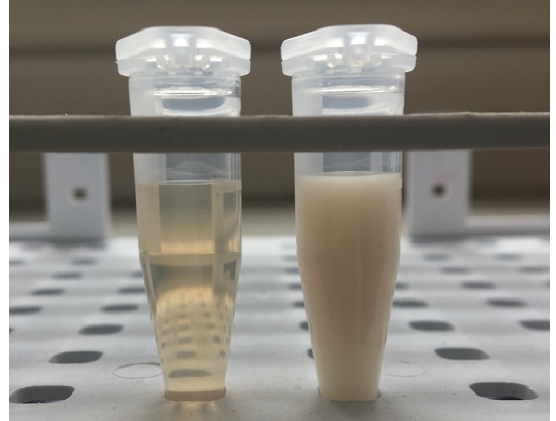
Figure 4. Apparent visual difference between the two matrixes used in the study, the normal rabbit plasma (on the left) and artificially produced lipemic samples obtained by Intralipid ® addition to the normal plasma (on the right).